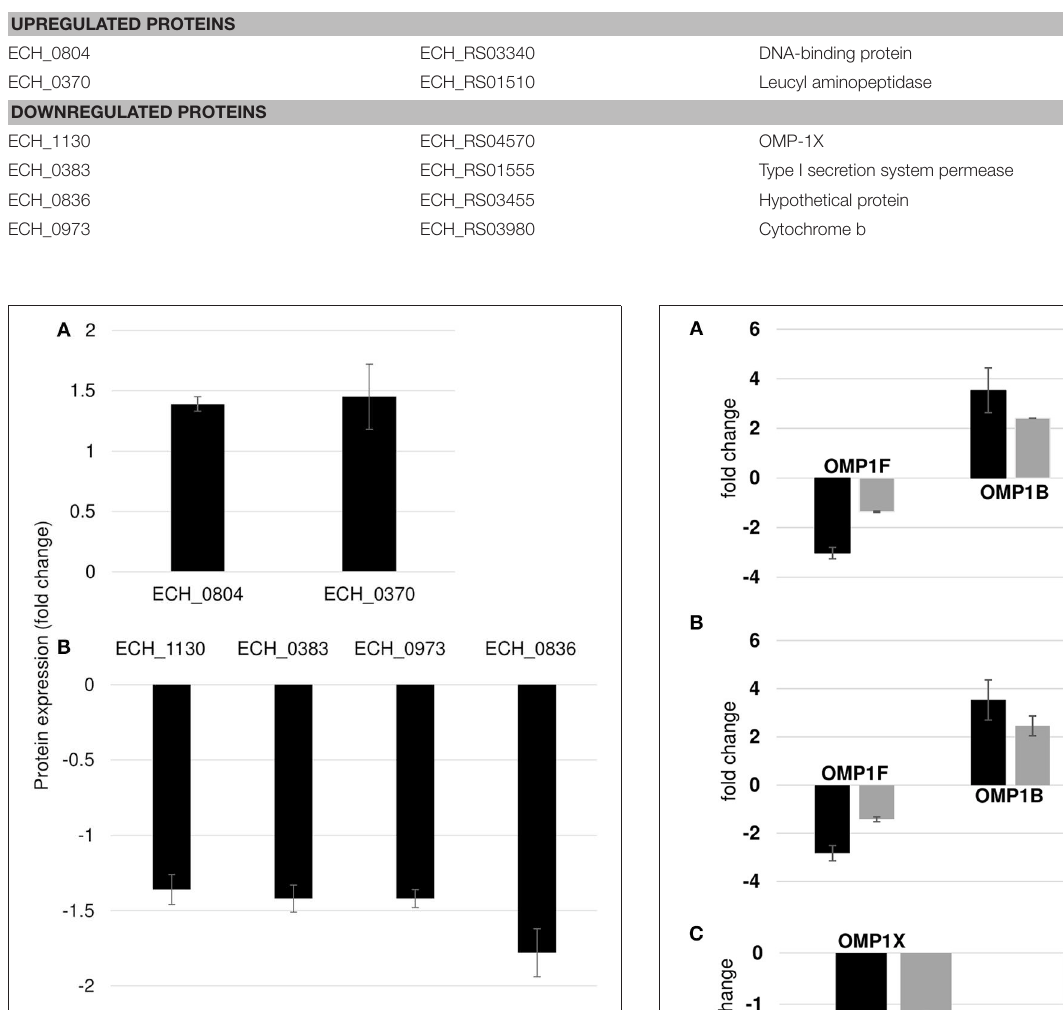
FIGURE 7 | Differentially expressed proteins in mutant ECH_0660. (A) , upregulated proteins; (B) , downregulated proteins. Protein expression was determined by comparing the expression values of mutant ECH_0660 and wildtype. The GenBank numbers are listed in Table 3 . Fold changes were considered significant with < 1% FDR at protein level and with a p -value was than 0.05.